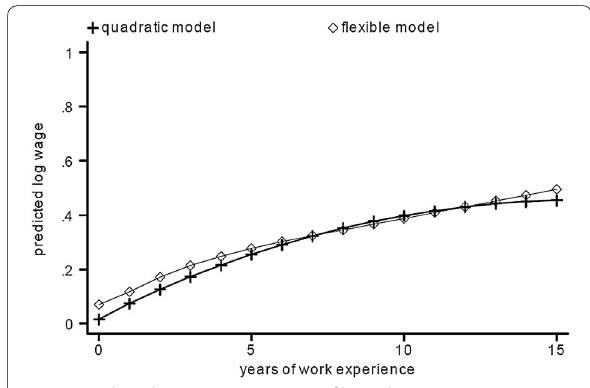
Fig. 1 Predicted wage-experience profile, males